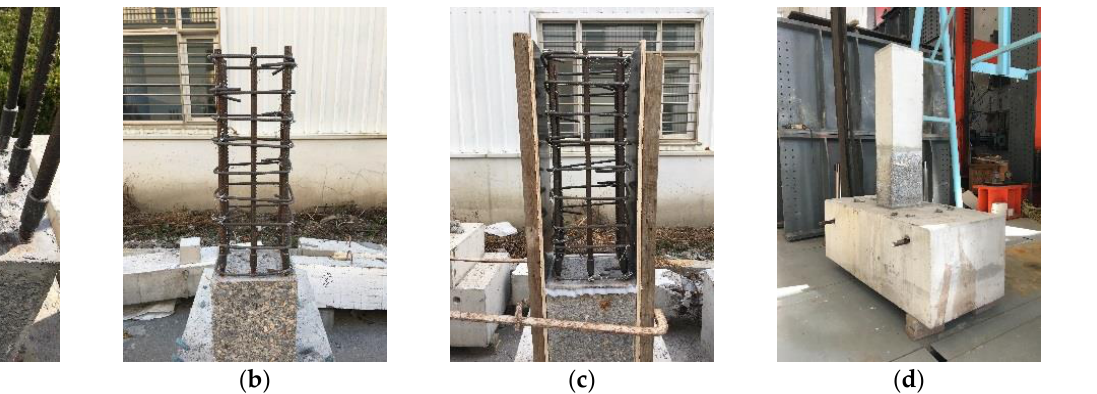
( f ) Figure 12. The main process of the second pouring. ( a ) Base cut hair. ( b ) Roughening of the F – T segment. ( c ) Laying the sealing material. ( d ) Artificial grouting. ( e ) Inserting freeze – thaw segments. ( f ) End of the assembly.